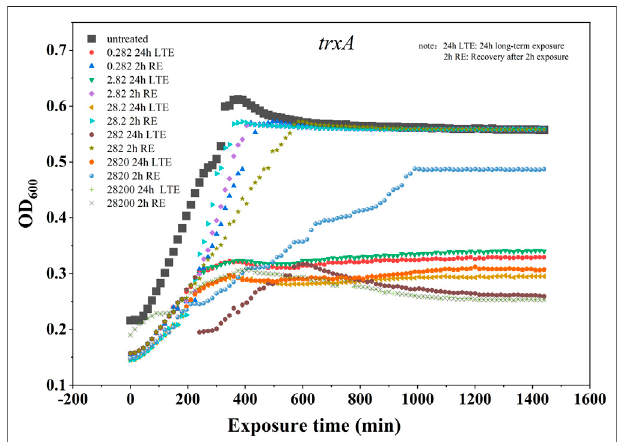
FIGURE8| E.coli growthcurveincluding trxA reporterin24-hlong-term exposure and recovery after 2-h exposure.